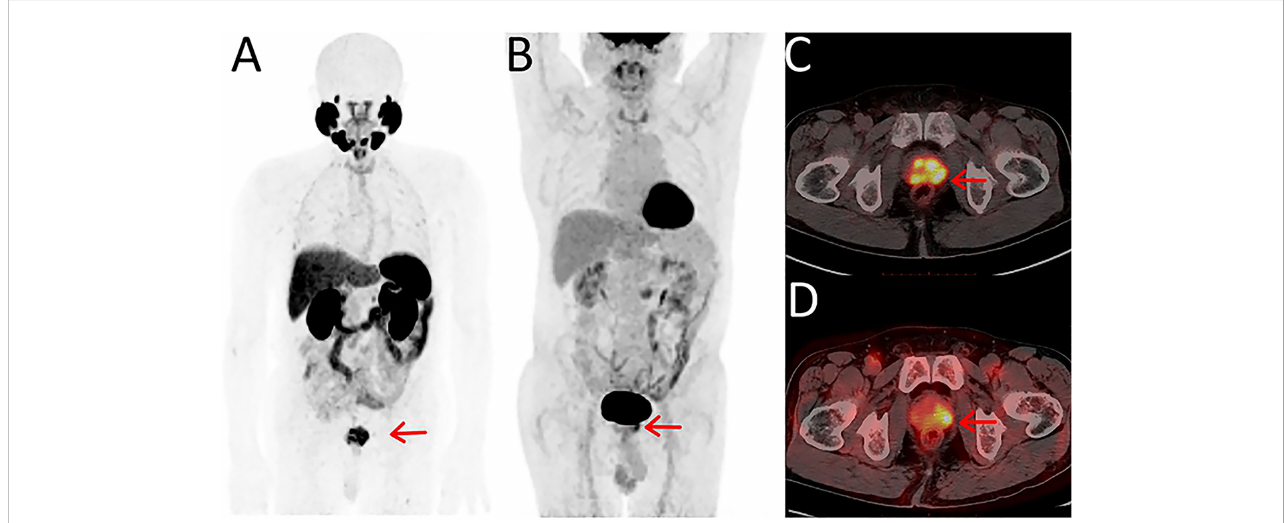
FIGURE 1 Maximum-intensity projections of PET examinations using 18 F-PSMA-1007 (A) and 18 F-FDG (B) . Axial PET/CT for 18 F-PSMA-1007 (C) and 18 F-FDG (D) . Reprinted with permission from Zhou et al. (9). Copyright © 2021 Zhou, Li, Jiang, Wang, Chen, Shen, You, Lu, Liao, Li and